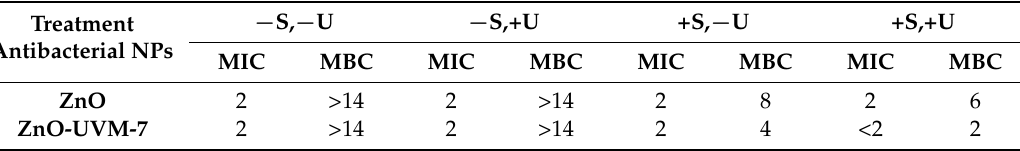
Table 1. MICs and MBCs of ZnO and ZnO-UVM-7 (Si/Zn = 5) suspensions in mg/mL, after 24